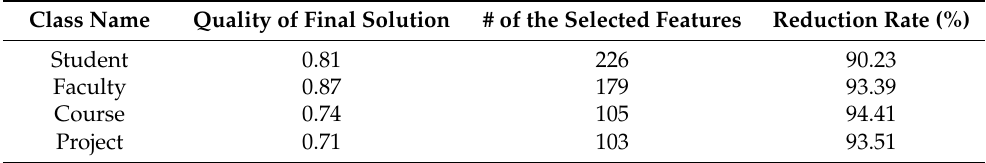
Table 9. Quality of the final solution, number of features and reduction rate of BBA CO in We- bKB